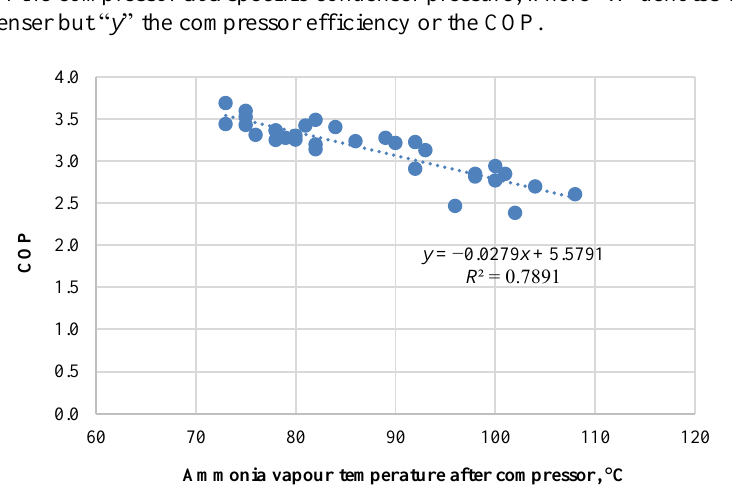
Fig. 7. Two-stage compressor COP depending on ammonia vapour temperature after